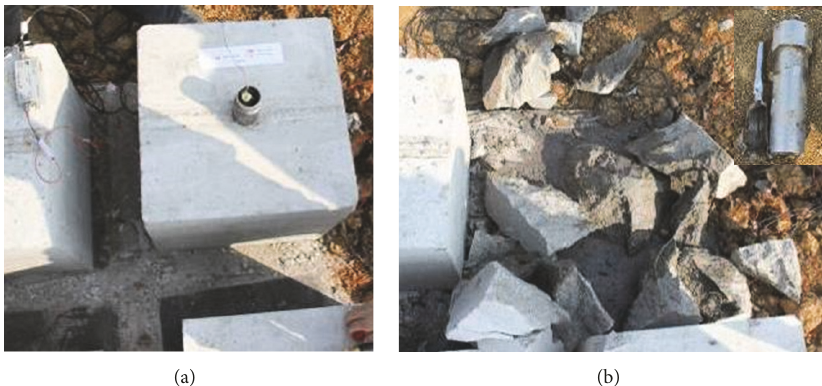
Figure 7: The states of the cement block in the A1B1C1 case: (a) before and (b) after being blasted.